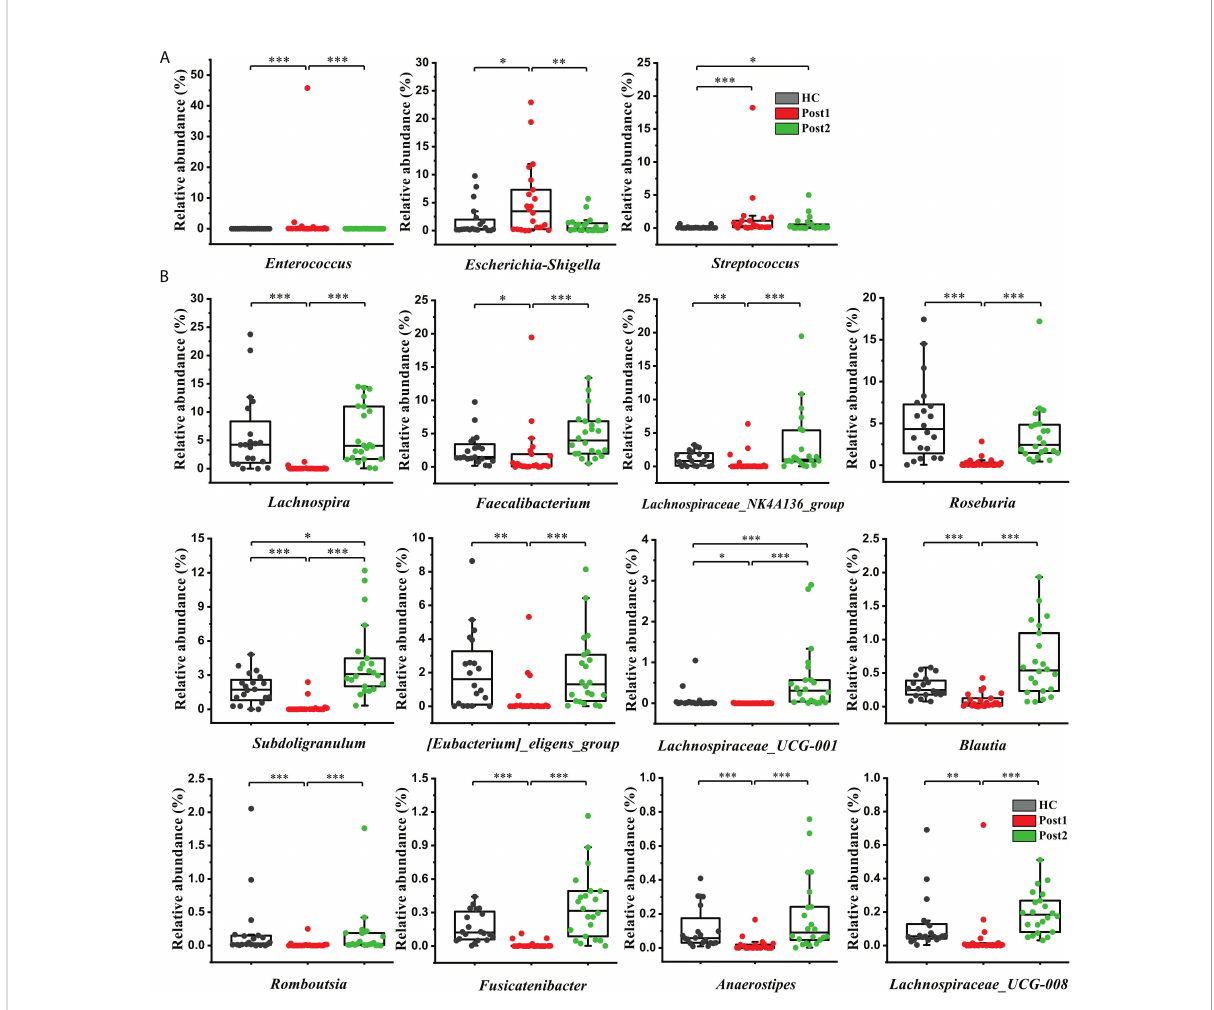
FIGURE 5 (A) Three opportunistic pathogens were enriched at Post1 ( n =22) compared with the healthy control group ( n = 20) but showed a declining tendency at Post2 ( n = 22). (B) Twelve SCFA-producing genera were signi fi cantly suppressed at Post1 ( n = 22), compared with the healthy control group ( n = 20), and were restored after SPD at Post2 ( n = 22). The box plot illustration is provided in Figure 2 , * P < 0.05, ** P < 0.01, *** P <